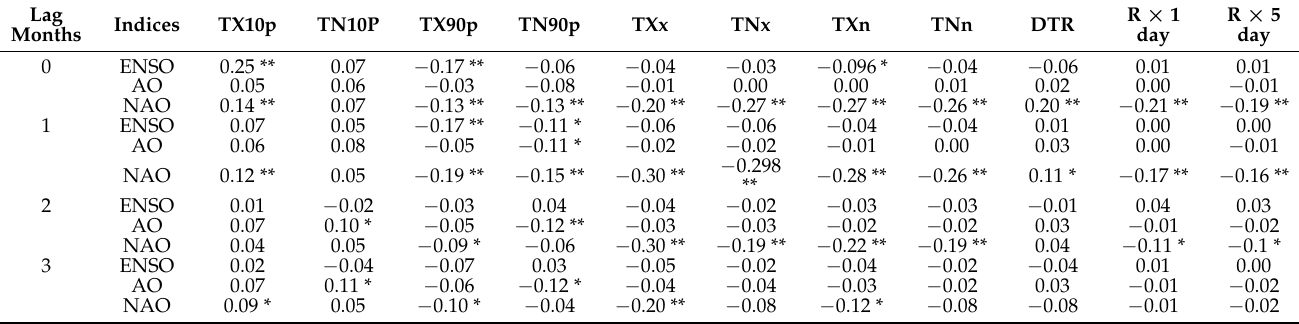
Table 5. Correlation coefficient between extreme climate indices at different time scales (monthly, quarterly, and annually) and general circulation patterns in